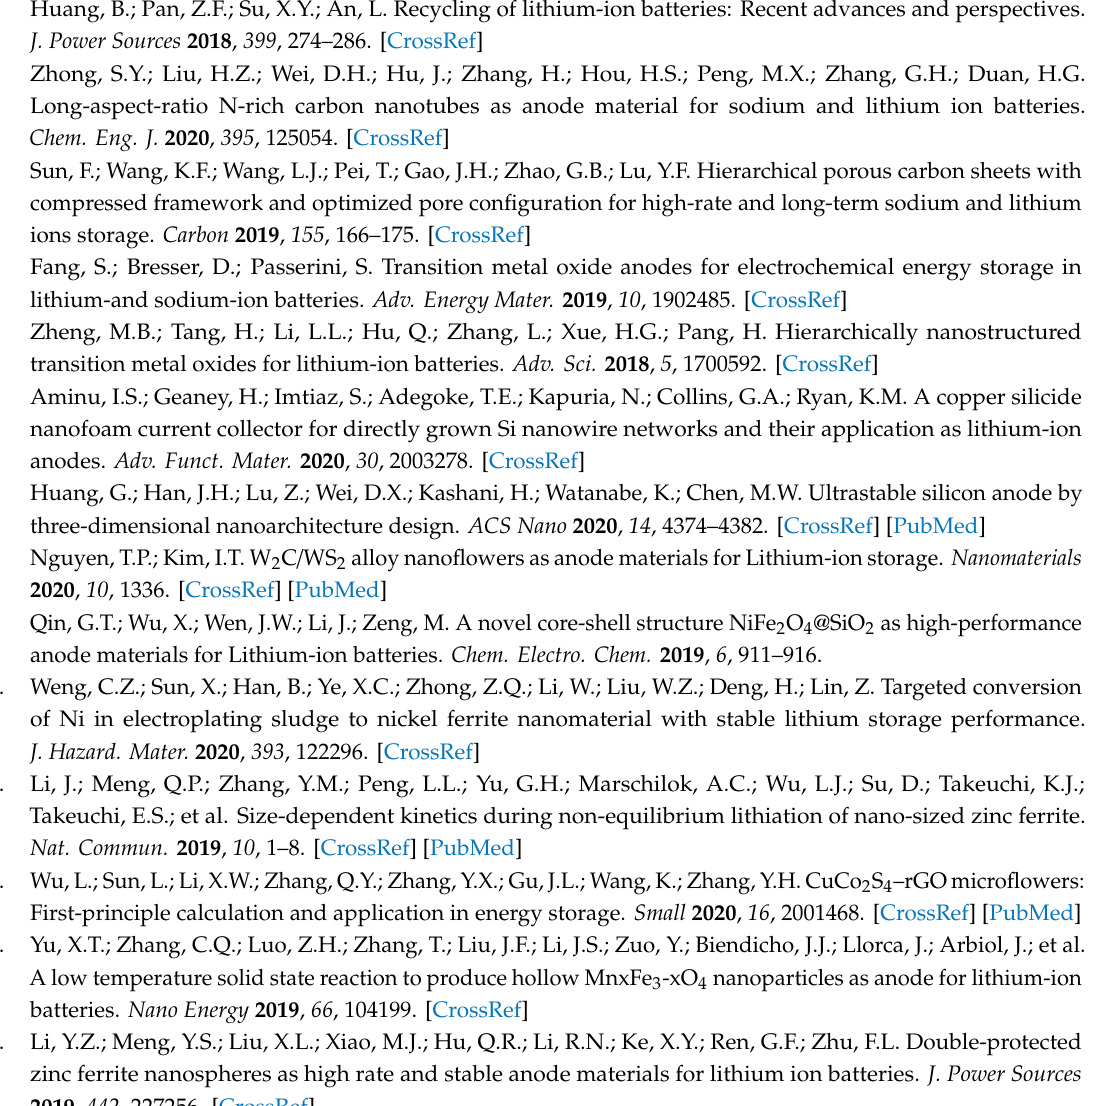
Figure S1: FESEM images of the NFO-S@C with (a) high- and (b) low- magnification, Figure S2: TEM images of the NiFe-glycerate precursors with (a) high- and (b) low- magnification, Figure S3: TEM image of the NFO-S@C, Figure S4: XPS spectra of C 1s for the sample of NFO-YS@C, Figure S5: TGA curve of